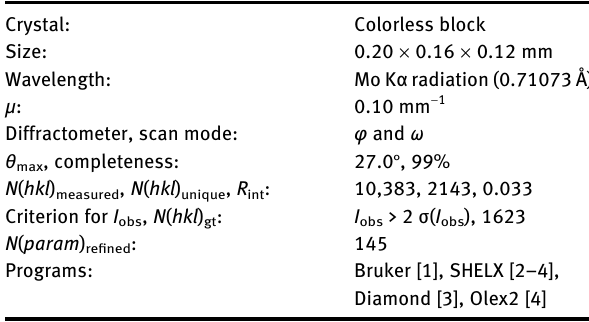
Table 1 contains crystallographic data and Table 2 contains the list of the atoms including atomic coordinates